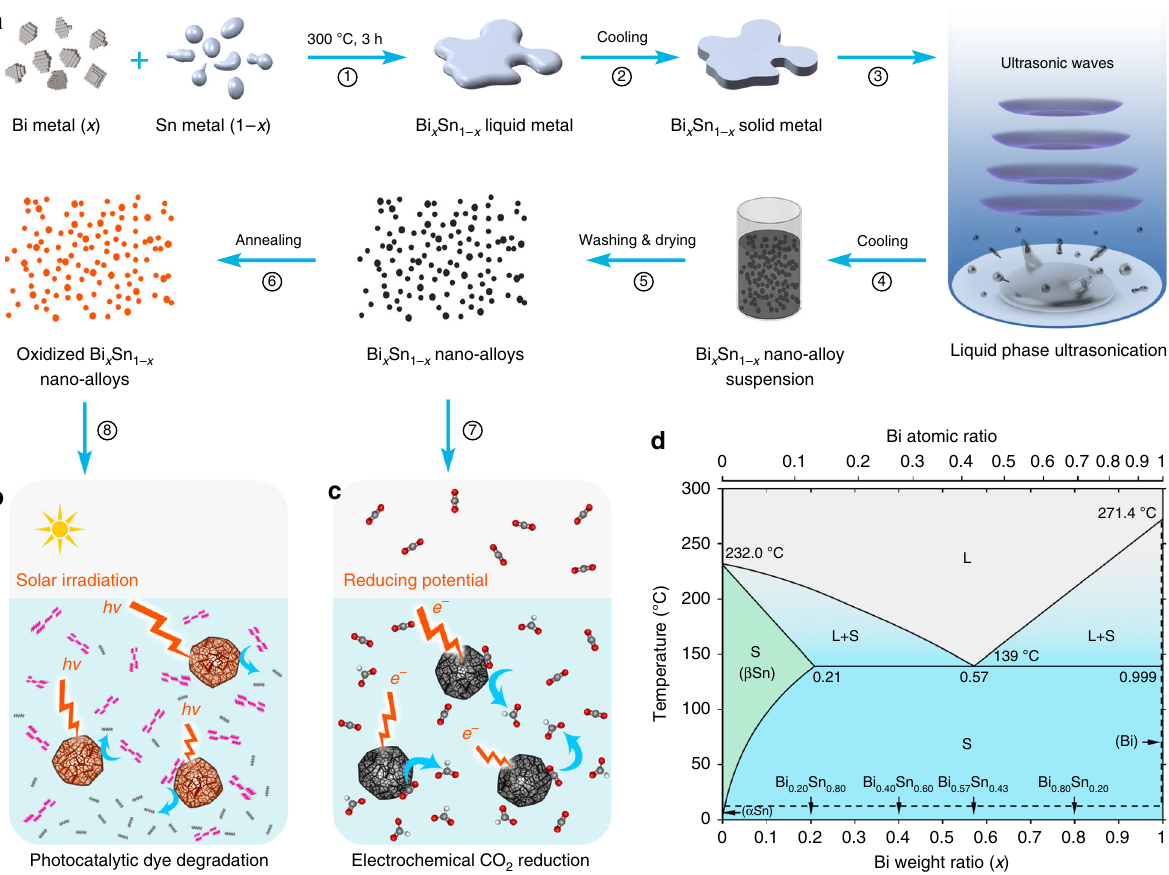
Fig. 1 Schematics of the strategy for fabricating Bi x Sn 1- x nano-alloy catalysts and the Bi – Sn phase diagram. a A fl ow chart showing the experimental procedures. b , c The Bi – Sn nano-alloys are used as catalysts for electrochemical reduction of CO 2 ( c ) and the annealed Bi – Sn nano-alloys are further used as catalysts for photocatalysis degradation of an organic model dye ( b ). d Bi – Sn binary alloy phase diagram (adapted from ref. 8 ) with the compositions used in this study indicated. L: liquid phase; S: solid